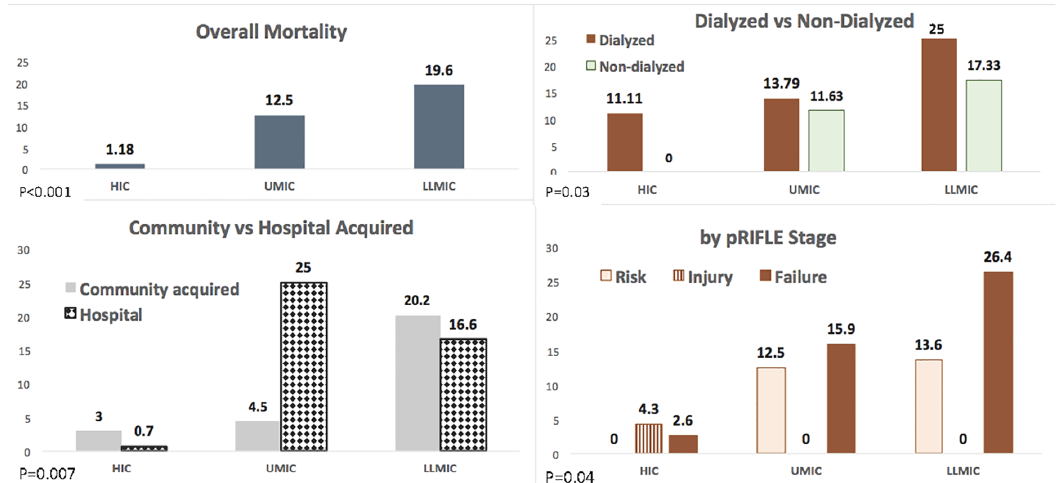
Fig 2. Mortality frequency in the overall cohort, and by AKI development location (community vs hospital acquired AKI), by need of ICU and renal replacement therapy. HIC: high income country; UMIC: upper middle-income country; LLMIC: low and lower middle income country. P values refer to difference within the GNI groups.